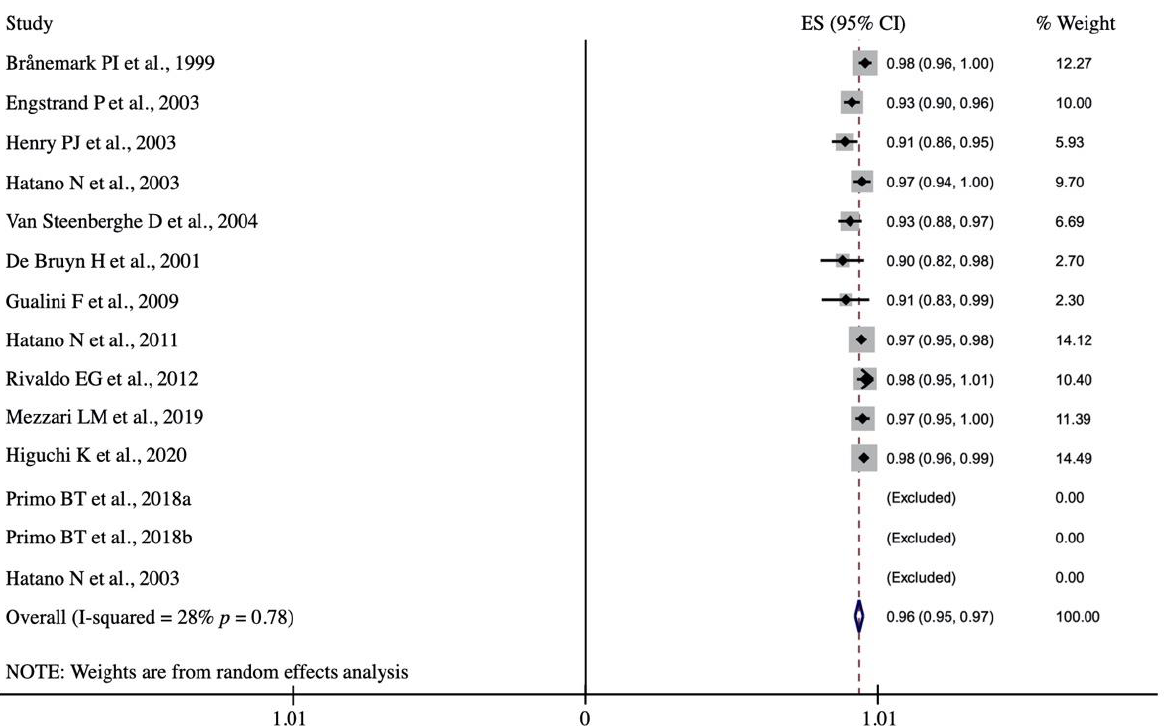
Figure 3. Forest plot. Prosthetic survival rate after 1–6-year follow-up. 3.3.4. Antagonist Dentition and Prosthetic Loading Protocols Antagonist dentition varied, with conventional complete dentures in three studies [1,26,28] and natural teeth, implants, or fixed tooth-supported restorations in seven studies [4–7,22,24,25]. Three studies did not report the type of antagonist dentition [23,27]. All the studies adopted immediate or early loading protocols; eight of them per- formed immediate loading exclusively (within 1–7 days), while the other five studies performed both immediate and early loading (within 1 week to 2 months) without dis- tinguishing between the two [29].